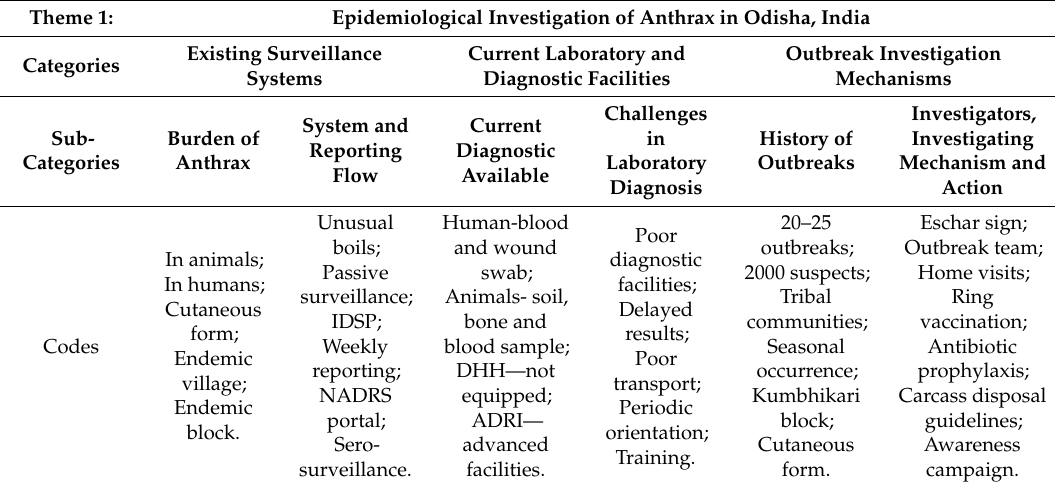
Table 2. Theme—Epidemiological investigation of anthrax in Odisha,